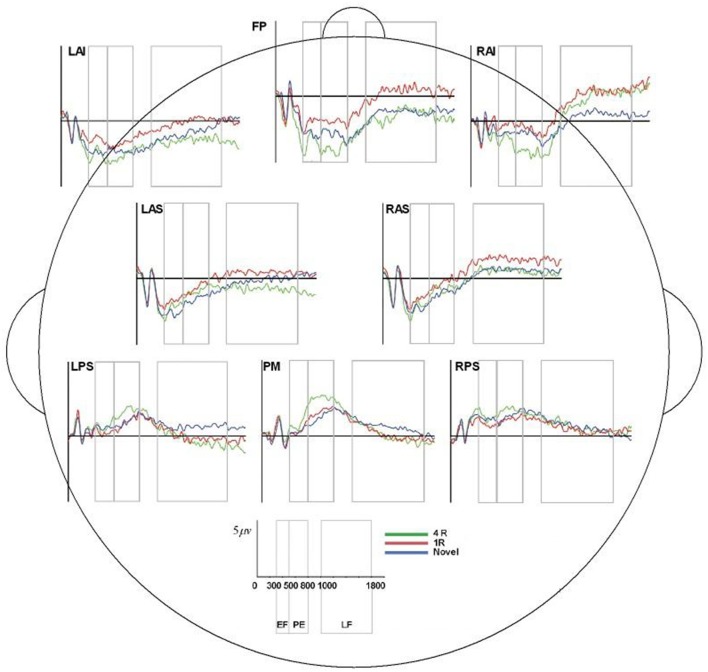
ERP, event-related potential; LAS, left anterior superior; FP, frontal pole; RAS, right anterior superior; LPS, left posterior superior; RPS, right posterior superior; PM, posterior medial; RAI, right anterior inferior; RAS, right anterior superior; 4R, presented 4 times; 1R, presented 1 time; N, Novel; EF, Early Frontal Effect, 300–500 ms; PE, Parietal Effect; 500–800 ms; LF, Late Frontal Effect; 1,000–1,800 ms. Average ERP wave forms for each region of interest (ROI) across the three conditions for processor A. X-axis represents time (in milliseconds) from 0 to 2,000, and Y-axis represents microvolts. Blue lines represent novel face-name (FN) pairs (correct rejections), red lines represent 1-time repeated (lR) FN pairs (hits), and green lines represent 4-times repeated (4R) FN pairs (hits).